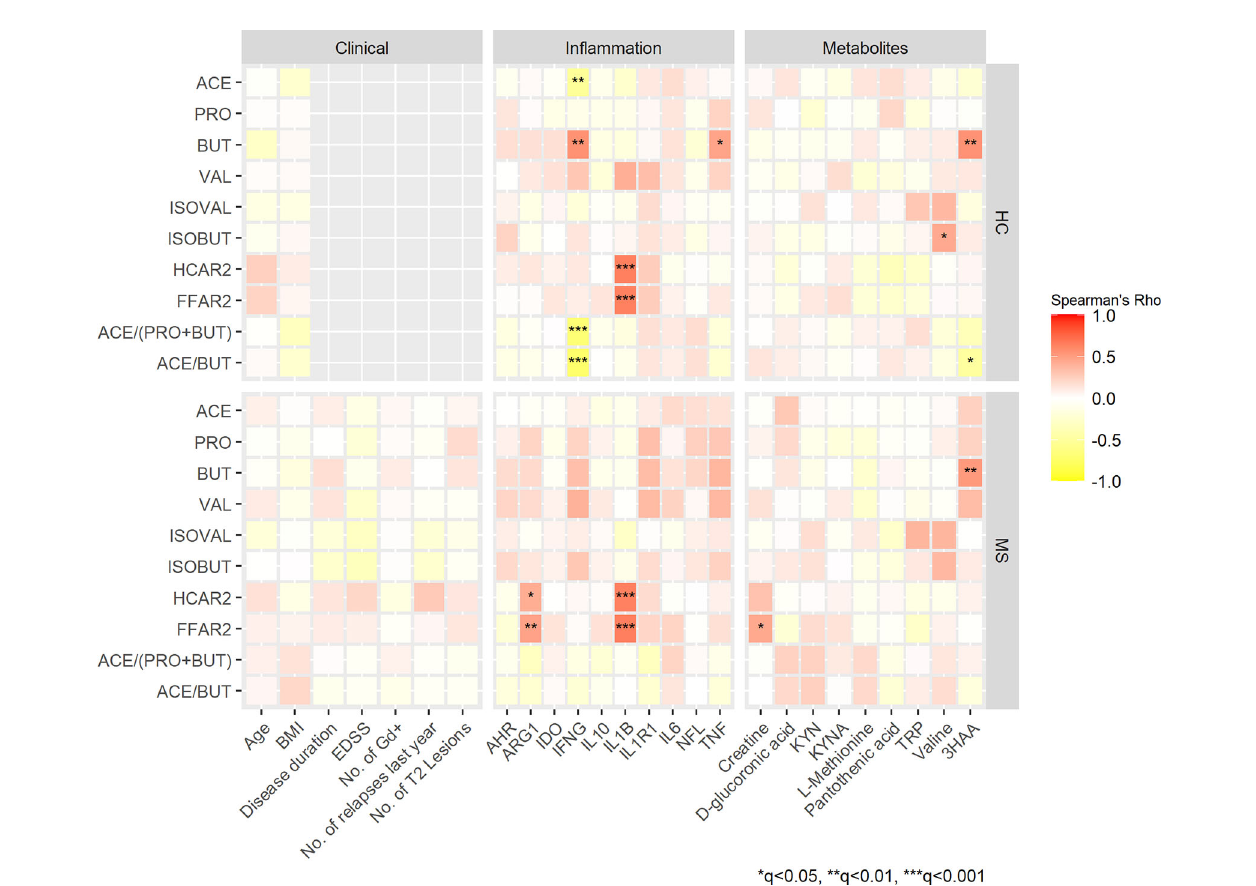
FIGURE 2 | Spearman ’ s correlation heatmap of the associations between SCFAs, clinical variables, biomarkers of in fl ammation and selected metabolites in patients with MS and HCs. Color gradients indicate rho values; positive correlations are marked in red, negative in yellow. Clinical measures that were not applicable for HCs are in grey. *q<0.05, **q<0.01 and ***q<0.001. ACE, acetate; PRO, propionate; BUT, butyrate; VAL. valerate; IVAL, isovalerate; IBUT; isobutyrate. HCAR2, hydroxycarboxylic acid receptor 2; FFAR2, free fatty acid receptor 2; BMI, body mass index; EDSS, expanded disability status scale, No. of Gd+, number of gadolinium enhancing lesions; AHR, aryl hydrocarbon receptor ARG1, arginase 1; IDO1, indoleamine 2,3-dioxygenase 1; IFNG, interferon-gamma; IL, interleukin; IL1B, IL-1 beta; IL1R1, IL-1 receptor type 1; NFL, neuro fi lament light chain; TNF, tumor necrosis factor; KYN, kynurenine; KYNA, kynurenic acid; TRP, tryptophan; 3HAA, 3-hydroxyanthranilic